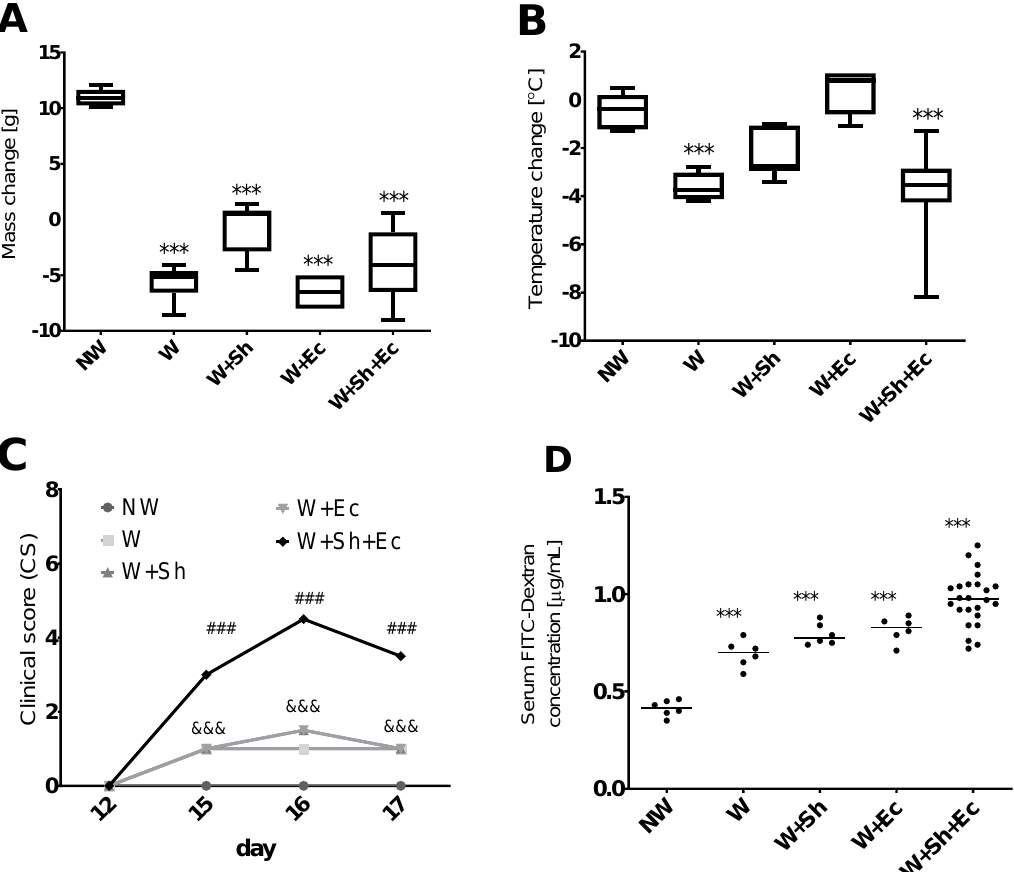
Figure 1. Clinical parameters of animals in tested groups: change in weight ( A ) and temperature ( B ) between the day of necropsy (day 17) and weaning (day 12). ( C ) Clinical scores (reduced motor activity, lethargy, shivering, piloerection) were assessed on days 12, 15, 16 and 17. FITC-Dextran concentration was calculated using standard curve. ( D ) *** p < 0.001 vs. NW, ### p < 0.001 vs. NW, W, W+Ec and W+Sh, &&& p < 0.001 vs. NW and W+Sh+Ec. NW-non-weaned control group,